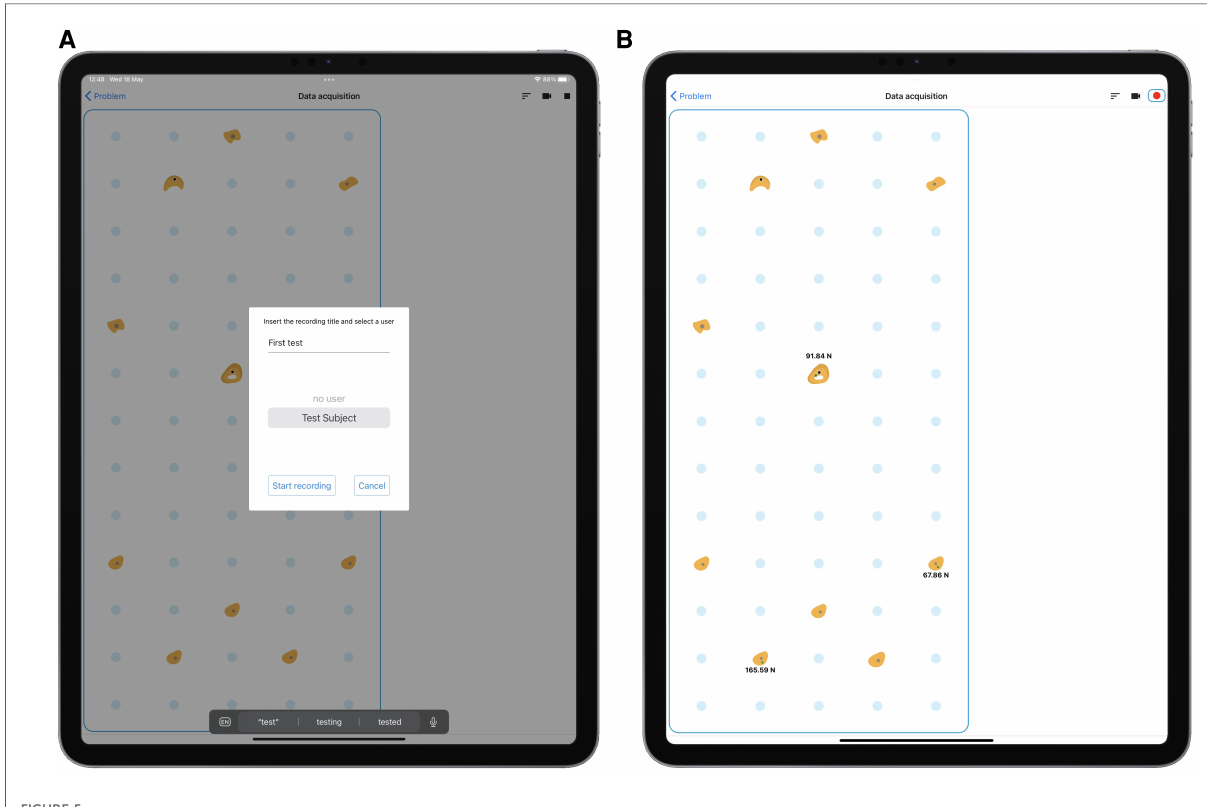
FIGURE 5 Data Acquisition environment. ( A ) User selection; ( B ) live